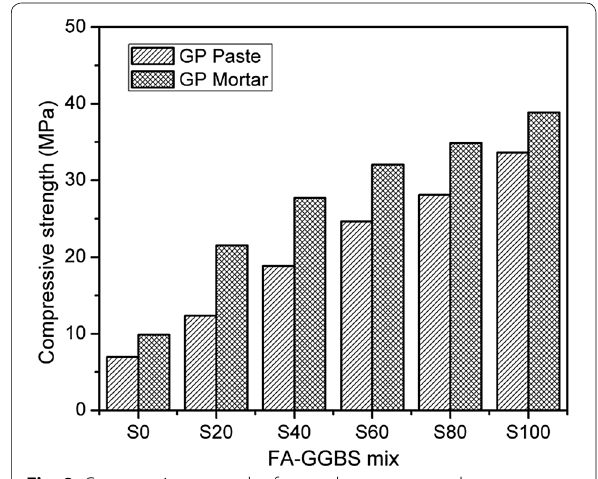
Fig. 8 Compressive strength of geopolymer paste and mortar.